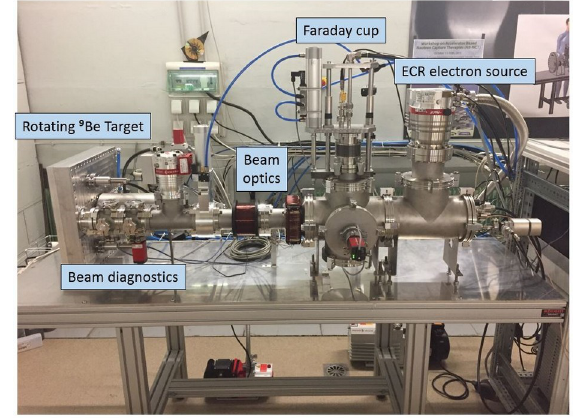
Fig. 3. Ion Beam Sputtering working principle